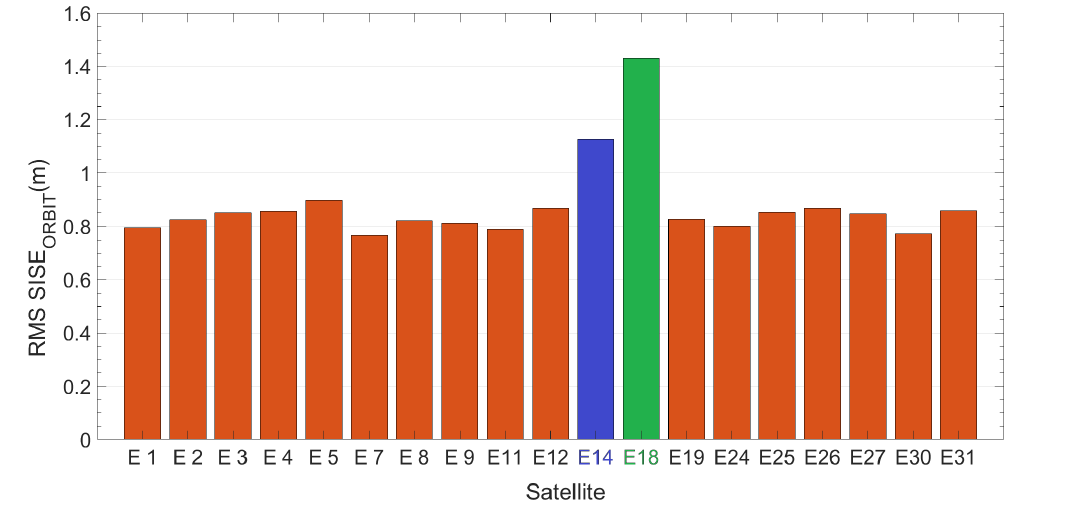
Figure 7. RMS SISE orbit calculated on the dataset of DOY 172–191 for all Galileo satellites. Blue and green are Milena (E14) and Doresa (E18) satellites, respectively. Ephemeris validity time threshold is set to 14,400